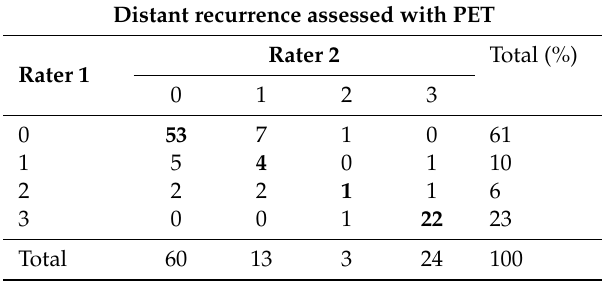
Table 2. Cross tabulations of raters 1 and 2 for assessment of distant recurrence with FDG-PET / CT, bone recurrence with FDG-PET / CT, and of rater 2 and 3 for bone recurrence with planar bone scintigraphy. Distant recurrence assessed with